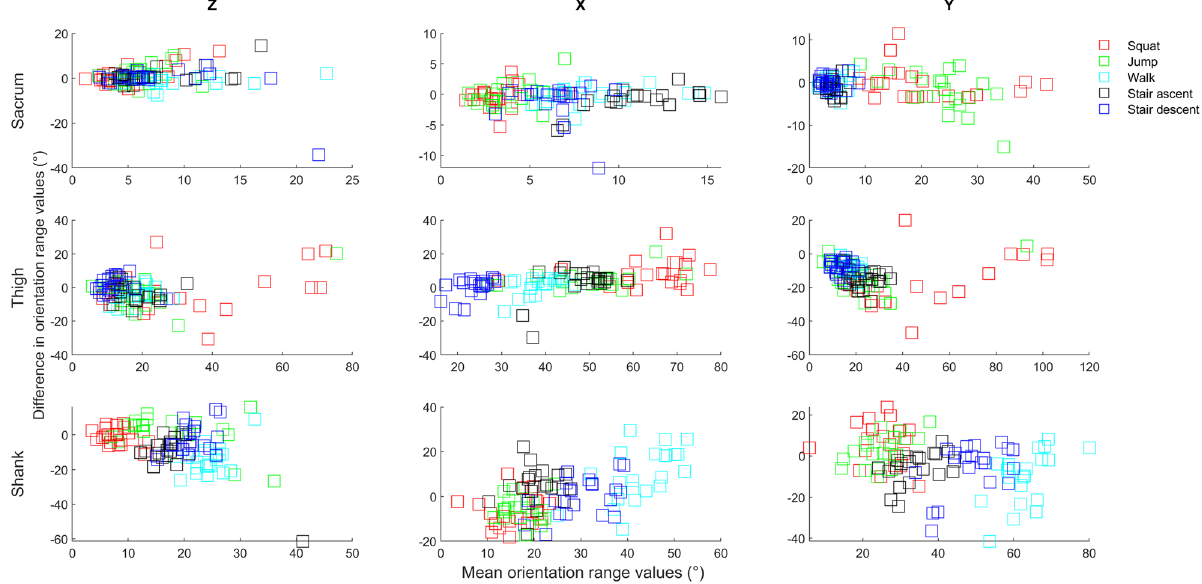
Figure 4. Bland–Altman plots portraying the agreement between the orientations (combined all activities) collected using the Xsens MTw and Xsens Dot. Y axis—Difference in orientation range values between the Xsens MTw and Xsens Dot; X axis—Mean orientation range values the Xsens MTw and Xsens